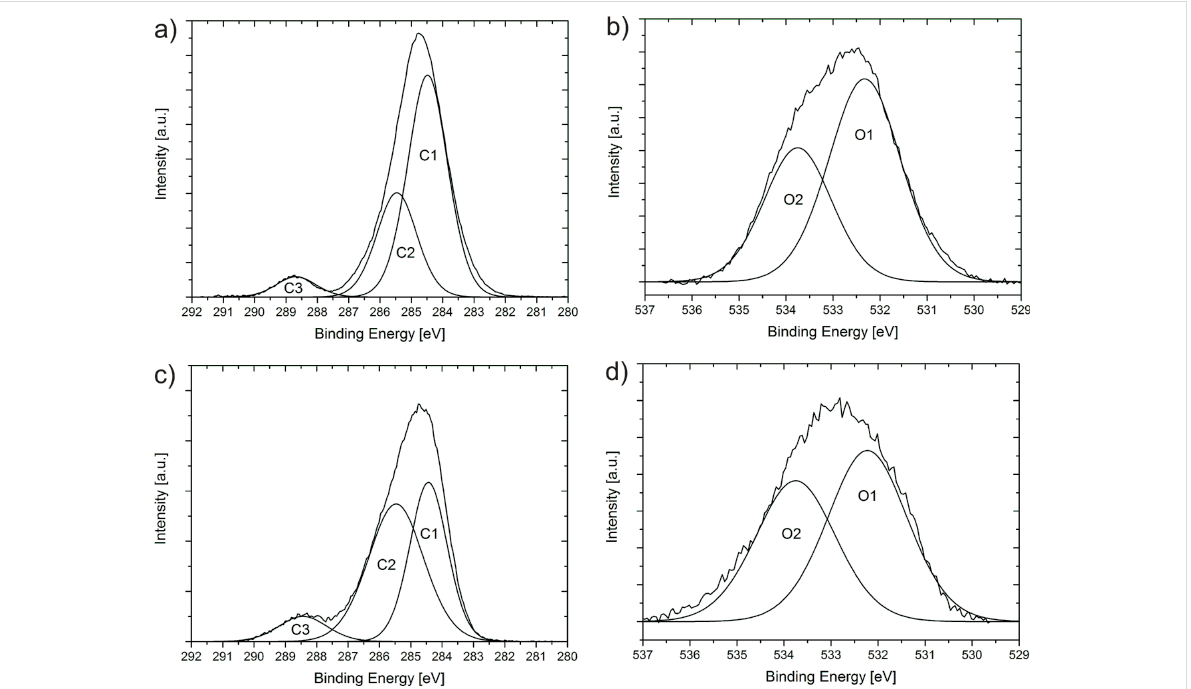
Figure 3: XPS spectra of low-density (a,b) and high-density (c,d) carbon nanofoams showing the C1s (a,c) and O1s (b,d) spectral distributions for low- and high-density foams, respectively.